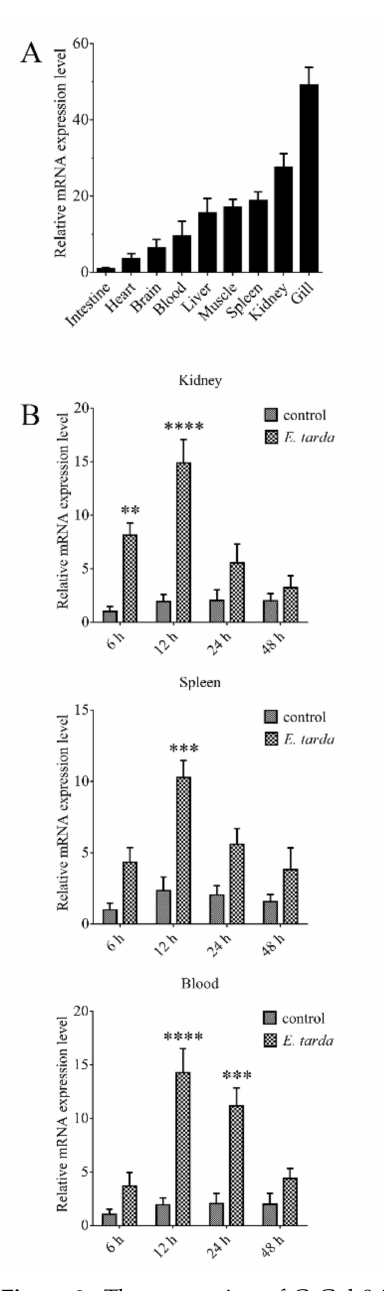
Figure 2. The expression of CsGal-8 in tongue sole tissues with and without bacterial infection. ( A ) CsGal-8 mRNA expression in the gill, kidney, spleen, muscle, liver, blood, brain and heart of tongue sole was determined by real-time-quantitative PCR (RT-qPCR). The expression levels are presented relative to that in intestine. ( B ) Tongue sole were infected with or without (control) Edwardsiella tarda for different hours, and the expression of CsGal-8 in blood, kidney and spleen was determined by RT-qPCR. Values are the means of three experimental replicates and shown as means ± S.D. ** p < 0.01, *** p < 0.001, **** p <